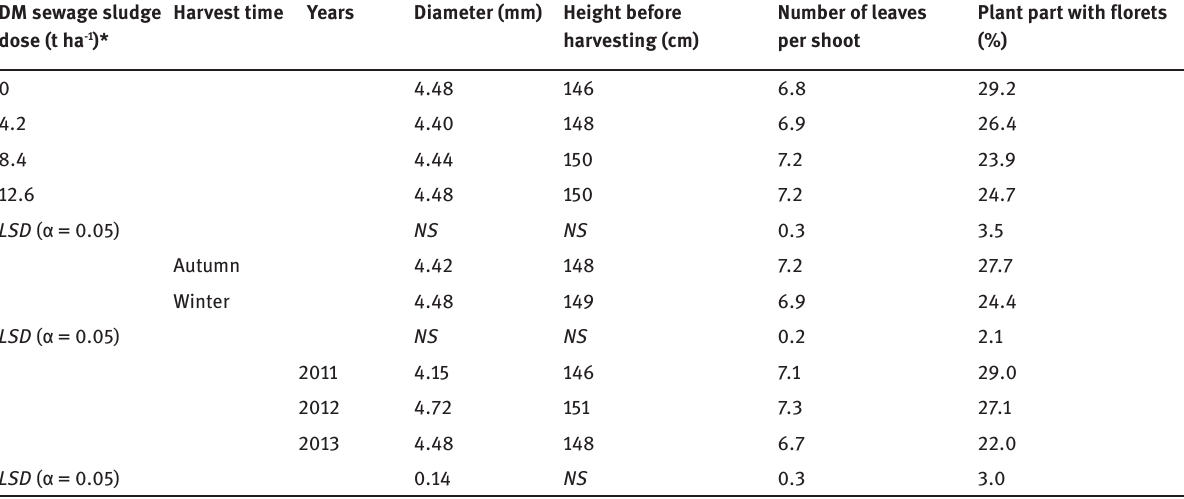
Table 5: Morphological features of Prairie cordgrass shoots (means by factors and years).